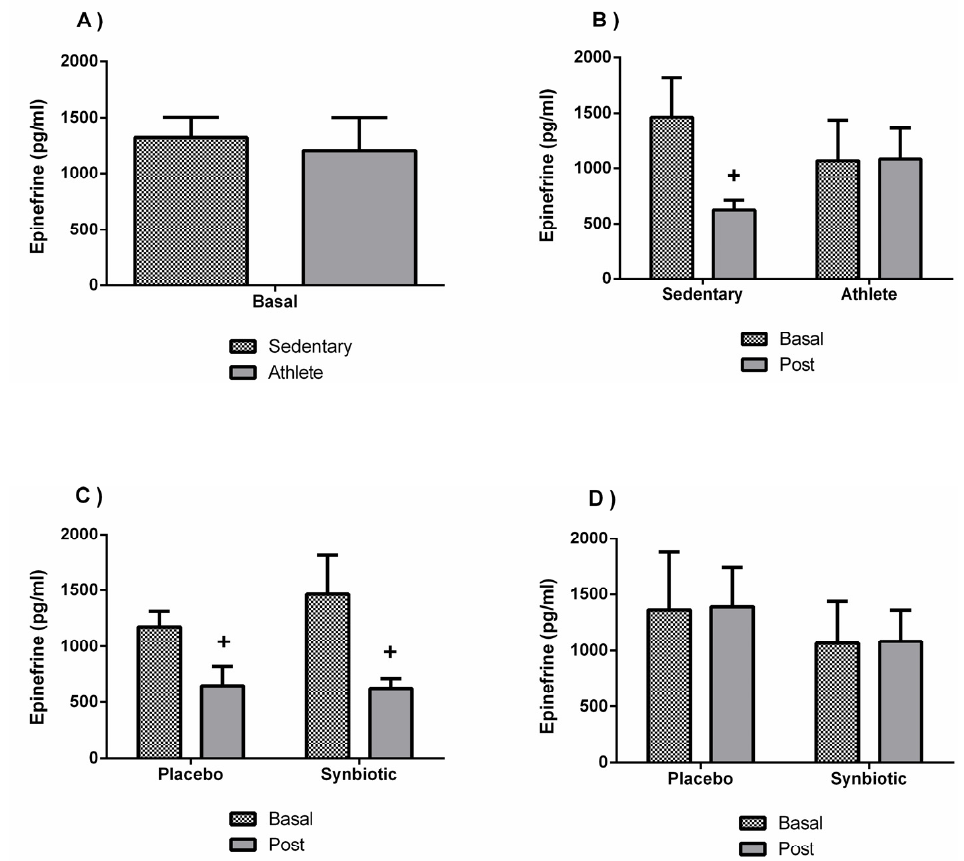
Figure 9. Effect of training and consumption of a synbiotic in this condition on epinephrine levels. ( A ) Concentrations of epinephrine in sedentary men ( n = 14) and athletes ( n = 13); ( B ) Influence of training on the effects of the synbiotic on the epinephrine ( n = 7 and n = 6 in sedentary and athlete groups, respectively); ( C ) Effect of the consumption of the synbiotic on epinephrine in sedentary individuals with respect to placebo ( n = 7) or with synbiotic ( n = 7); ( D ) Effect of the consumption of the synbiotic on epinephrine in athlete individuals with placebo ( n = 6) or with synbiotic ( n = 7). The determinations are expressed by the mean ± SD of each of the samples. + p < 0.05 with respect to the baseline.